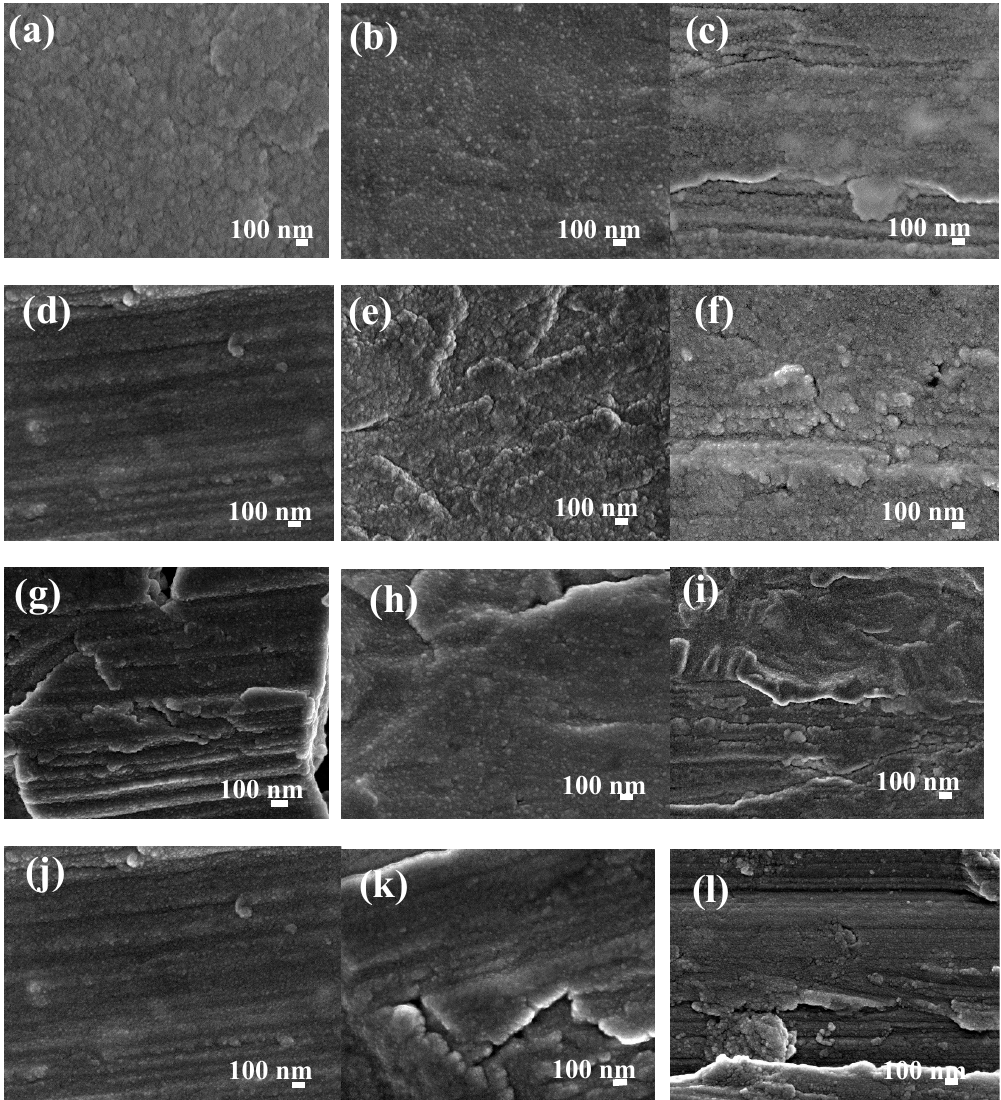
Figure 4. High Resolution Scanning Electron Microscopy (HRSEM) images of Ce coatings on AA6061 aluminum alloy substrates: ( a ) P 60 T 80 t 25 , ( b ) P 60 T 80 t 40 , ( c ) P 60 T 80 t 60 , ( d ) P 60 T 200 t 25 , ( e ) P 60 T 200 t 40 , ( f ) P 60 T 200 t 60 , ( g ) P 80 T 80 t 25 , ( h ) P 80 T 80 t 40 , ( i ) P 80 T 80 t 60 , ( j ) P 80 T 200 t 25 , ( k ) P 80 T 200 t 40 , and ( l ) P 80 T 200 t 60 .